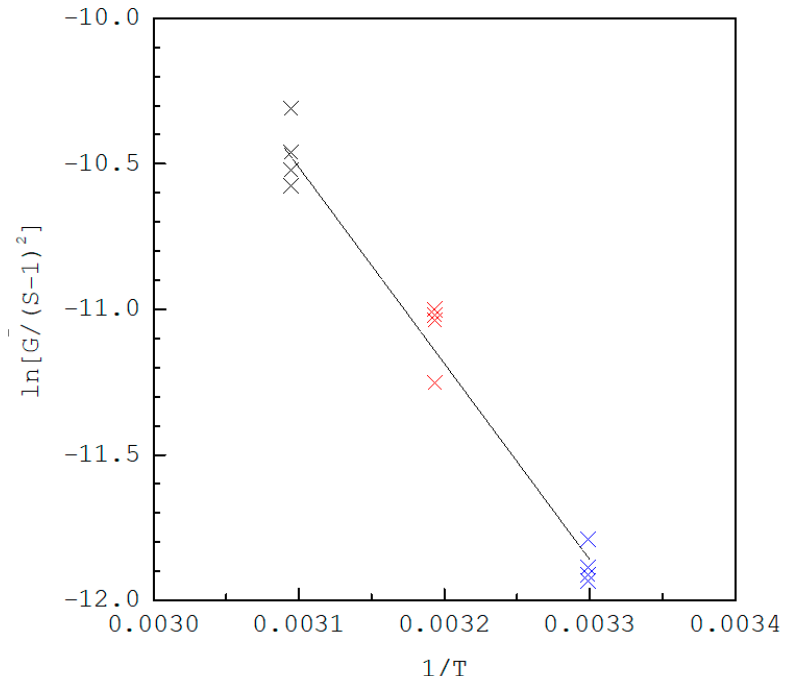
Figure 9. The growth rate data of L-glycine for various supersaturations at 303.15–323.15 K fitted to Equation (14).